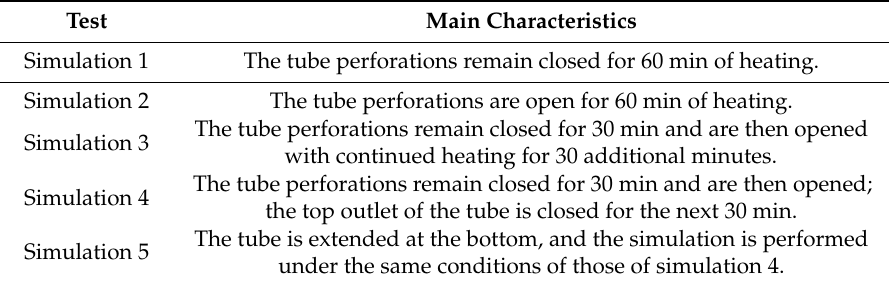
Table 3. Characteristics of transient simulations in heating